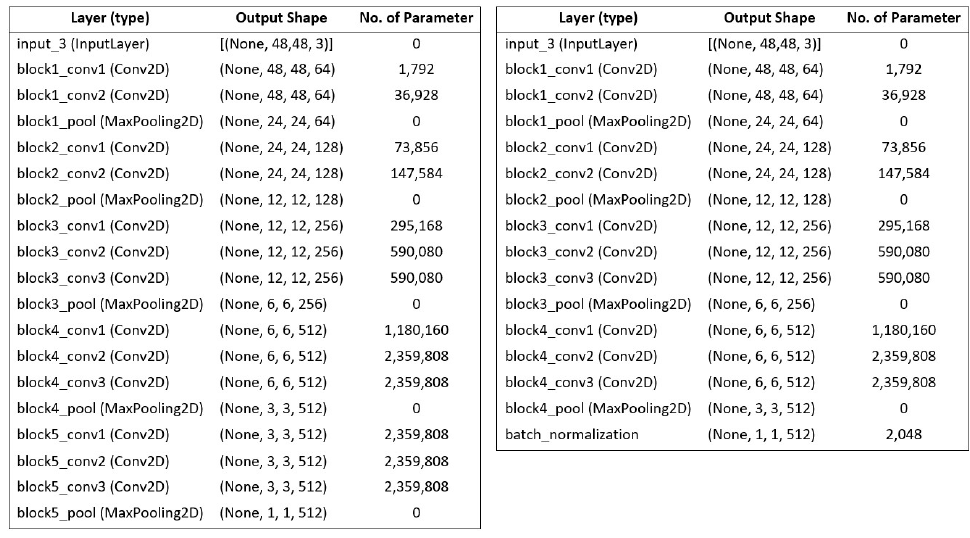
Figure 3. The model architecture of ( left ) the original VGG16 and ( right ) the proposed lightweight